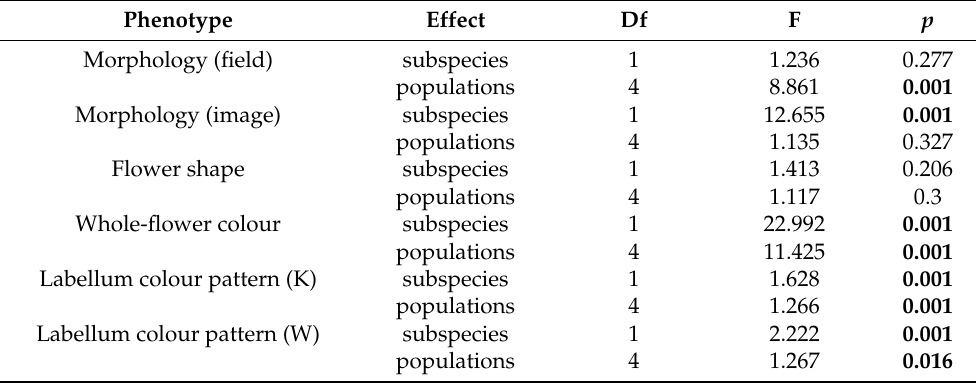
Table 2. Phenotypic differences in morphology, flower shape, colour, and labellum colour pat- tern between Ophrys aveyronensis subspecies and populations (within subspecies) as estimated by PERMANOVA